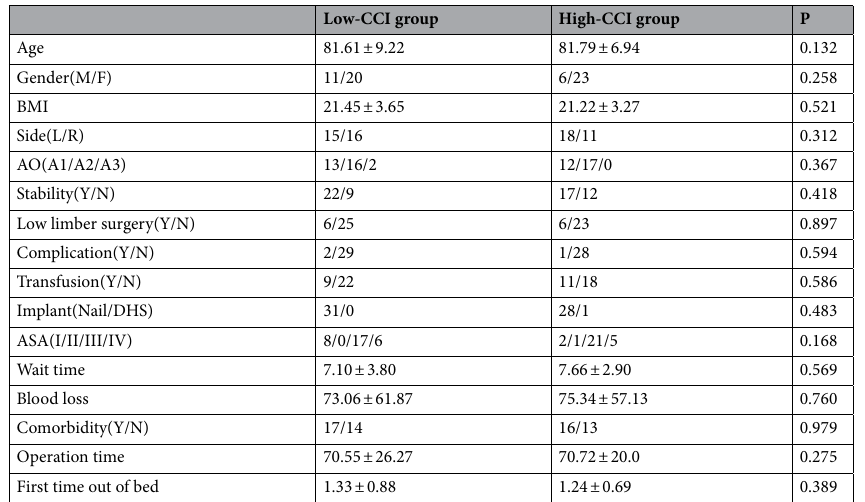
Table 1. The baselines of patients from the low- and high-CCI groups (Created by SPSS 24.0 software). ASA American Society of Anesthesiologists Classification; Gender(M/F): Gender(Male/Female); Side(L/R): Side(Left/Right); Stability: the fracture is stable or not; Low limber surgery: the patient has low limber surgery before or not; Complication(Y/N): the patient has complication before or not; Transfusion(Y/N): the patient has blood transfusion before or not; Comorbidity(Y/N): the patient has comorbidity or